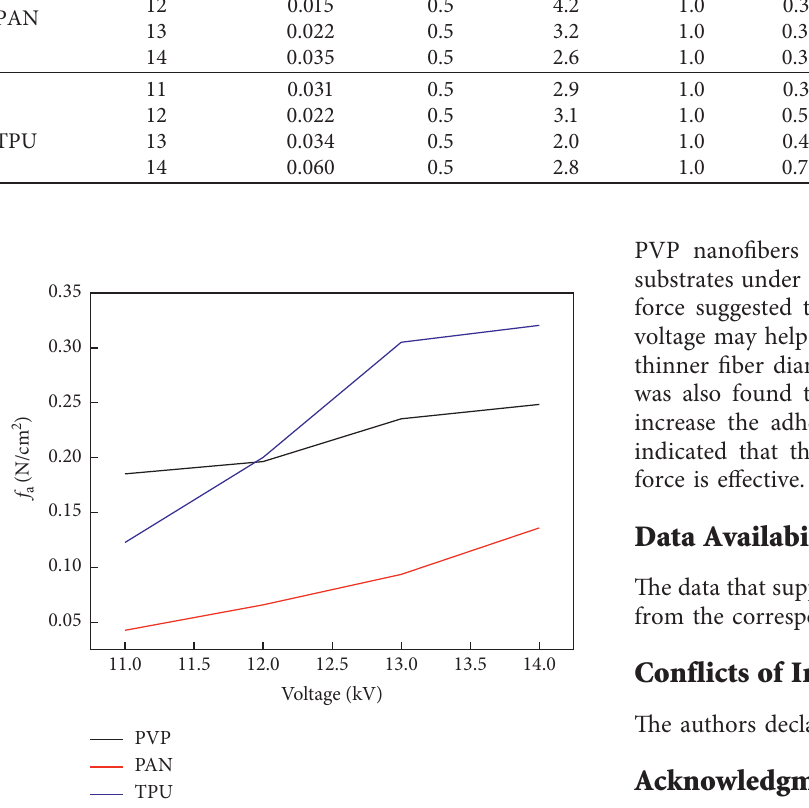
Figure 7: With the increase of spinning voltage, the adhesion of different fibers on aluminium foil